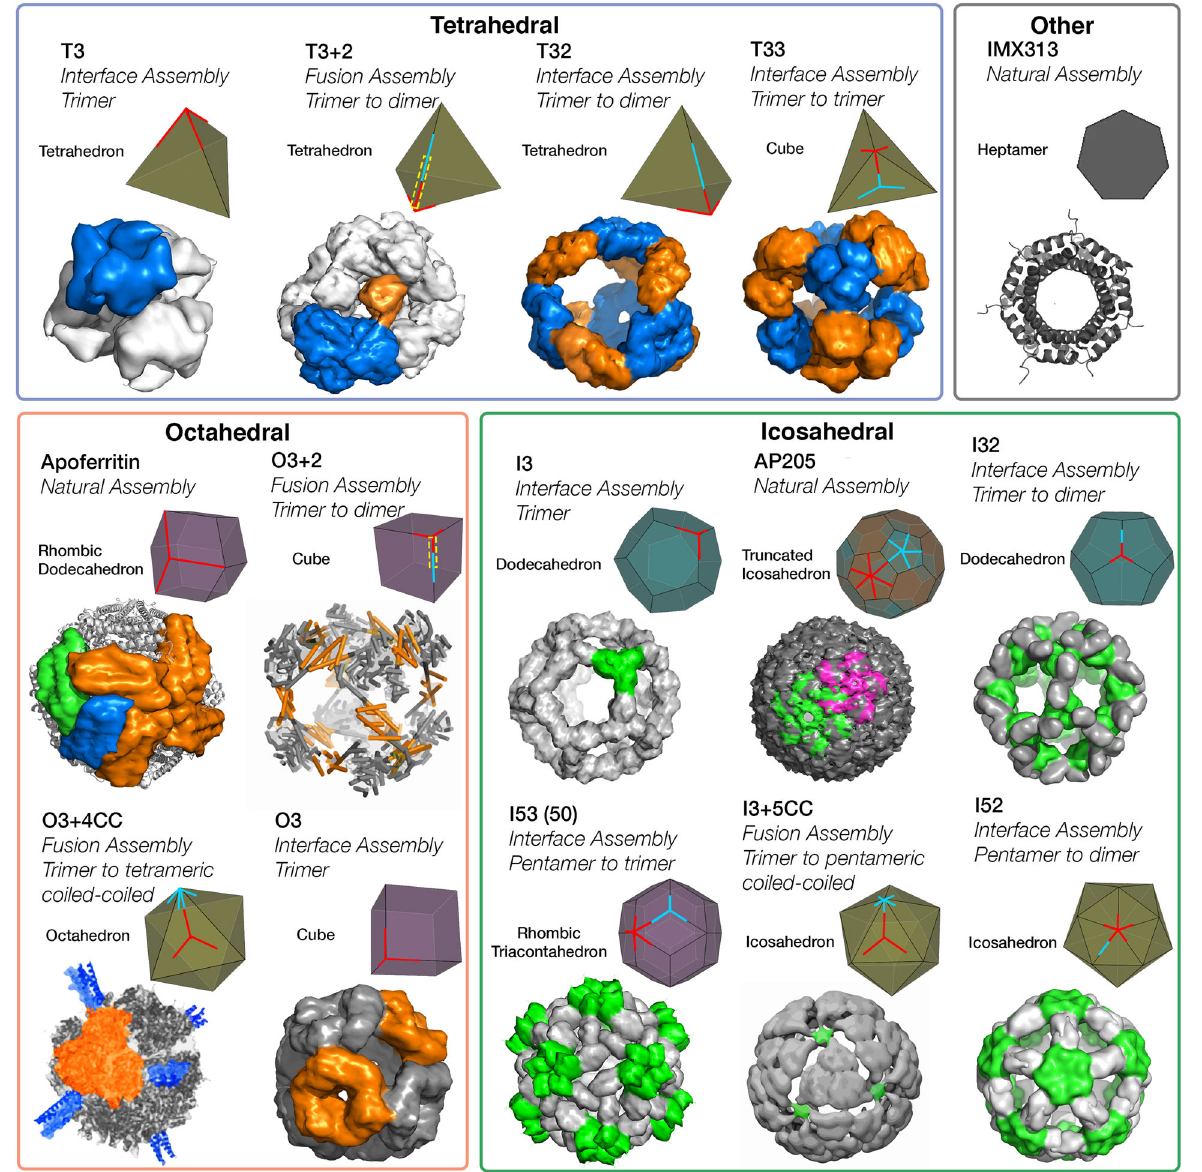
Fig. 4 Summary of published engineered self-assembling nanoparticles and naturally assembling nanoparticles, sorted by symmetry type. For the names of engineered nanoparticles, the fi rst letter indicates symmetry of the design T, O, or I for tetrahedral, octahedral, icosahedral, respectively. The fi rst number indicates the oligomeric state of the primary building block, while the second number represents the oligomeric state of the secondary building block, if present in the design. The abbreviation “ CC ” stands for a coiled-coil motif. A plus ( + ) between the fi rst and second number indicates that self-assembly is generated by genetic fusion between two monomers of the primary and secondary building block, versus Interface design with Rosetta. As a visual aid, the primary building block (red) and secondary (cyan) are aligned to the vertices or faces of a polyhedra 98,99 that resembles the geometry of the nanoparticle. Genetically fused building blocks are emphasized with a yellow-dashed